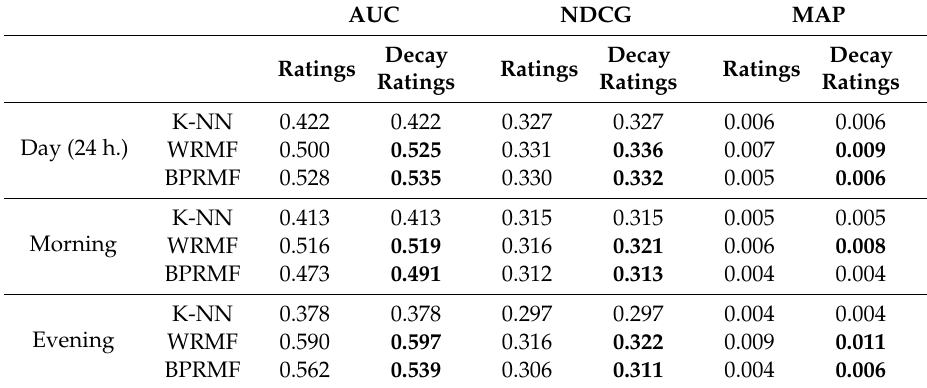
Table 3. The area under the receiver operating characteristics (ROC) curve (AUC), normalized discounted cumulative gain (NDCG), and mean average precision (MAP) values obtained for the rating prediction when contextual information is not considered (day) and when contextual pre-filtering is performed (morning and evening). AUC NDCG